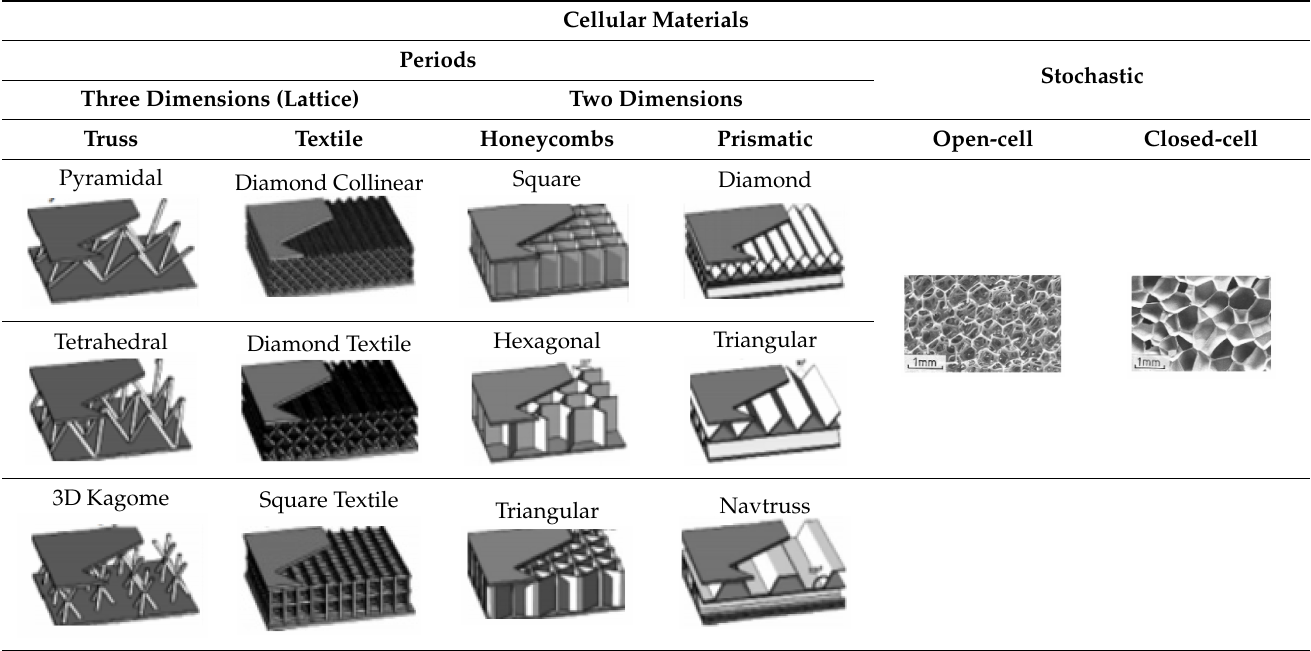
Table 2. Classification of cellular materials as sandwich structures cores